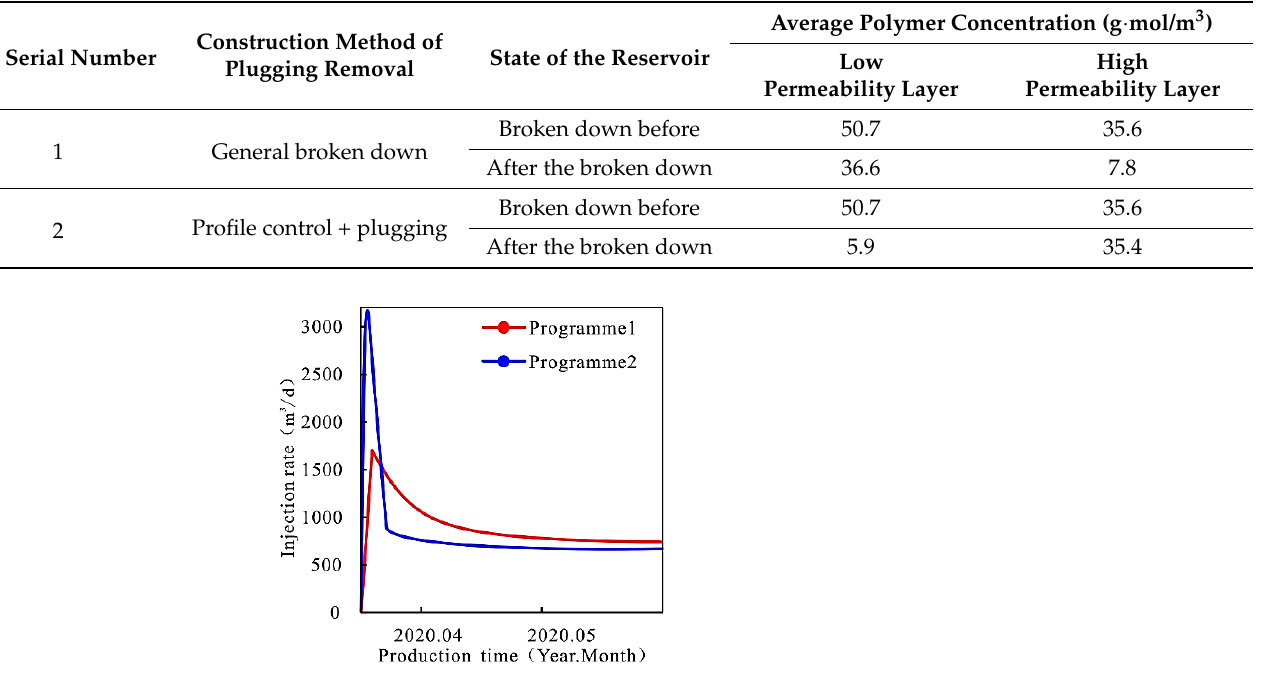
Table 7. Average polymer concentration in the vicinity of the wellbore.